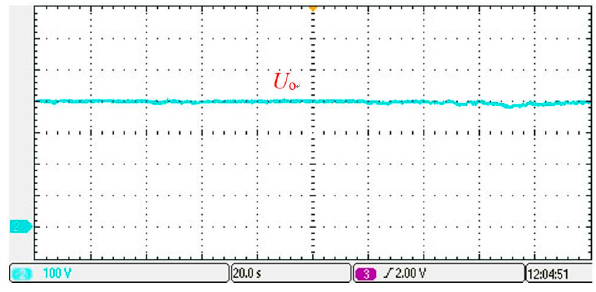
Figure 21. The output current waveform of the fuel cell under the WLTP. Appl. Sci. 2019 , 9 , x FOR PEER REVIEW